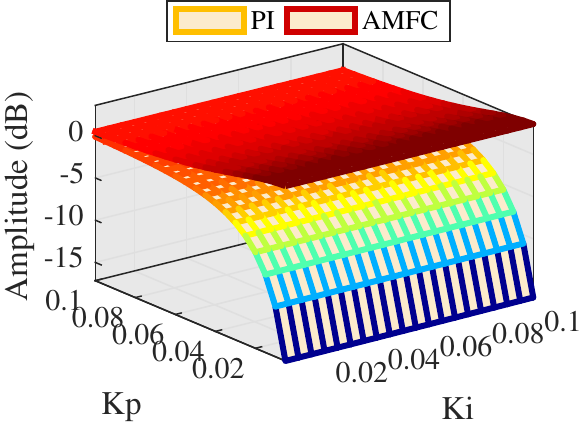
Figure 13. Amplitude comparison between PI and AMFC α = 1.5.